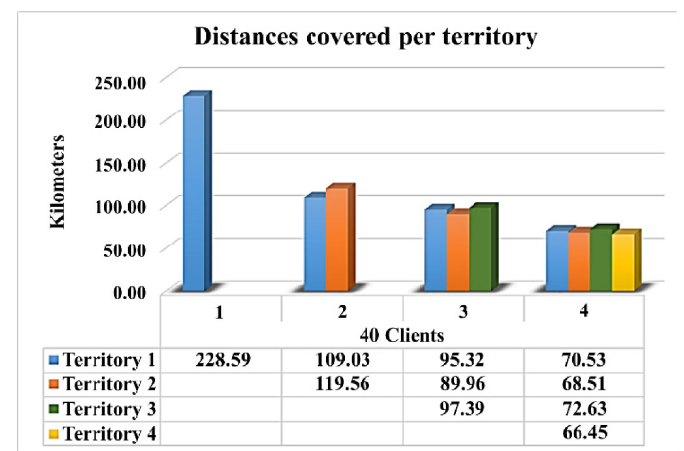
Figure 1. Graph of the layout of the distances covered (km) in each territory